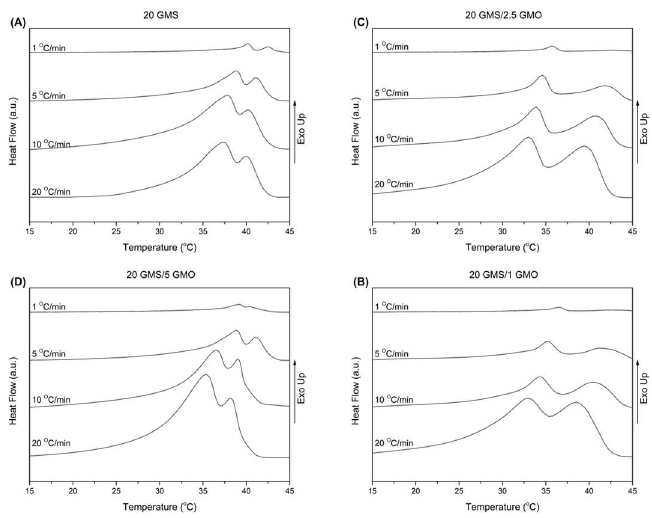
Figure 1. DSC cooling curves for cooling rates of 1, 5, 10, and 20 °C/min for ( A ) 20 GMS, ( B ) 20 GMS/1 GMO, ( C ) 20 GMS/2.5 GMO, and ( D ) 20 GMS/5 GMO. ( B ) 20 GMS/1 GMO, ( C ) 20 GMS/2.5 GMO, and ( D ) 20 GMS/5